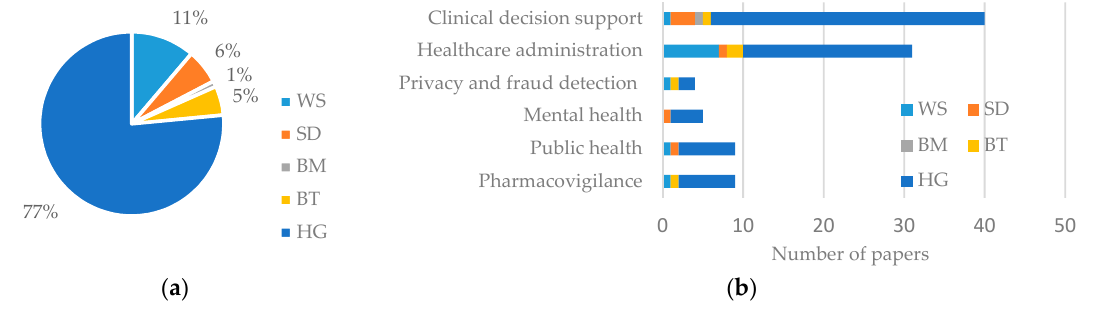
Figure 7. Percentage of data type used ( a ) and type of data used by application area ( b ).